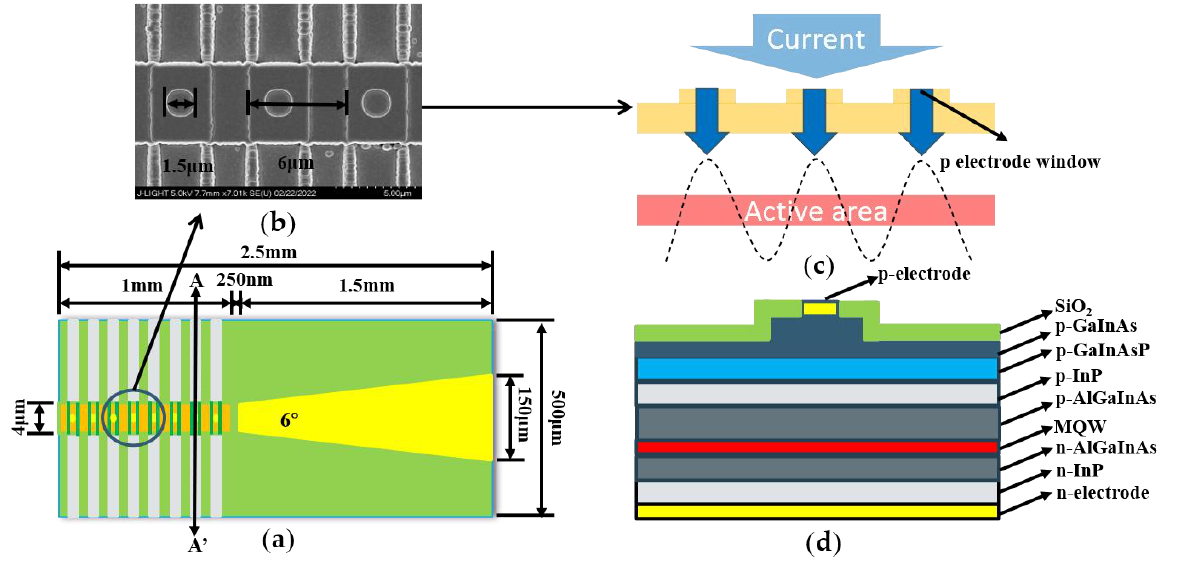
Figure 1. ( a ) Overview of the device; ( b ) SEM schematic diagram of grating and p-electrode window; ( c ) schematic diagram of carrier distribution for periodic electrical injection; ( d ) schematic cross- sectional view at AA’ of the overview of the device.